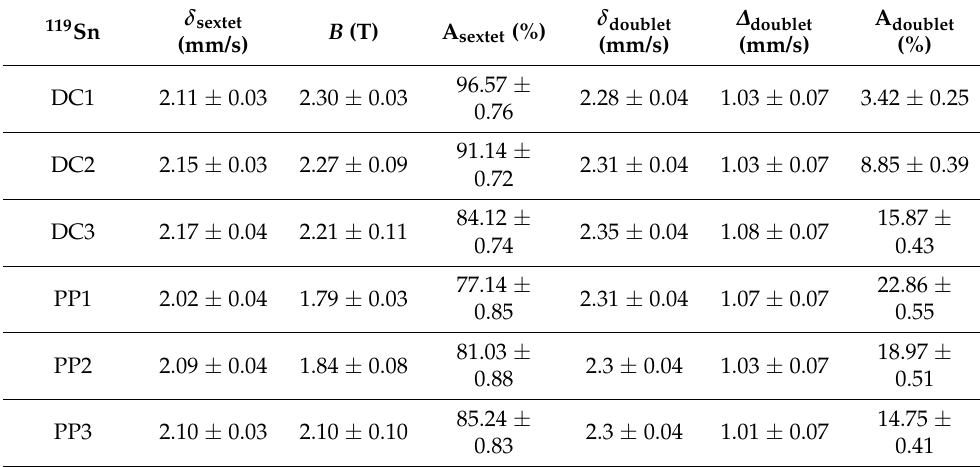
Table 4. Mössbauer parameters derived from 119 Sn CEMS of DC and PP electrodeposited quaternary Sn-Fe-Ni-Co